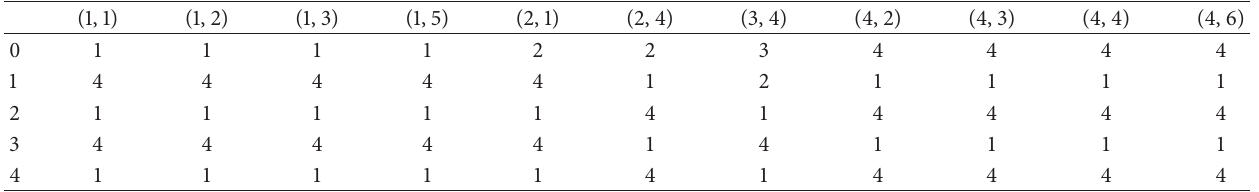
Table 2: An example of edge label propagation. The row numbers express edges, the column numbers express iteration times, and elements express edge label identifier.